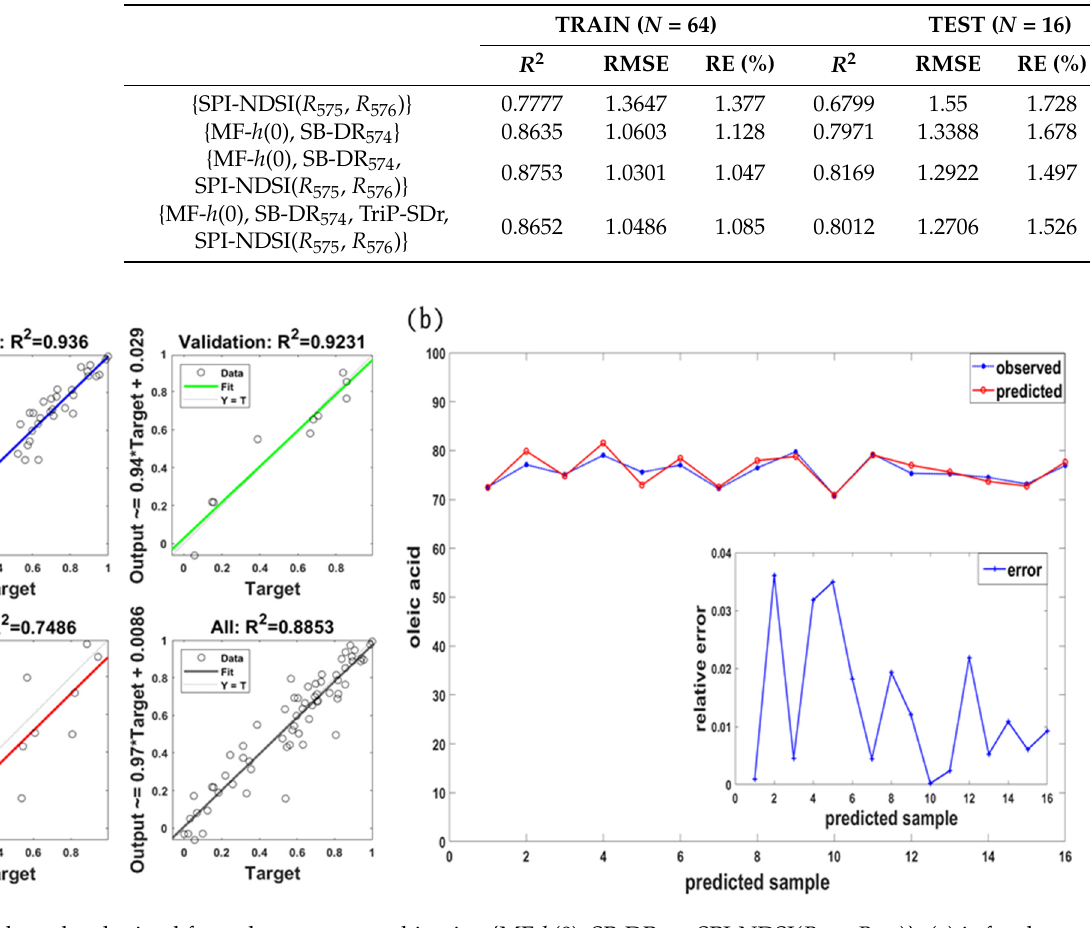
Figure 4. Model results obtained from the ternary combination {MF- h (0), SB-DR 574 , SPI-NDSI( R 575 , R 576 )}. ( a ) is for the 64 training samples. ( b ) is for the 16 testing samples.